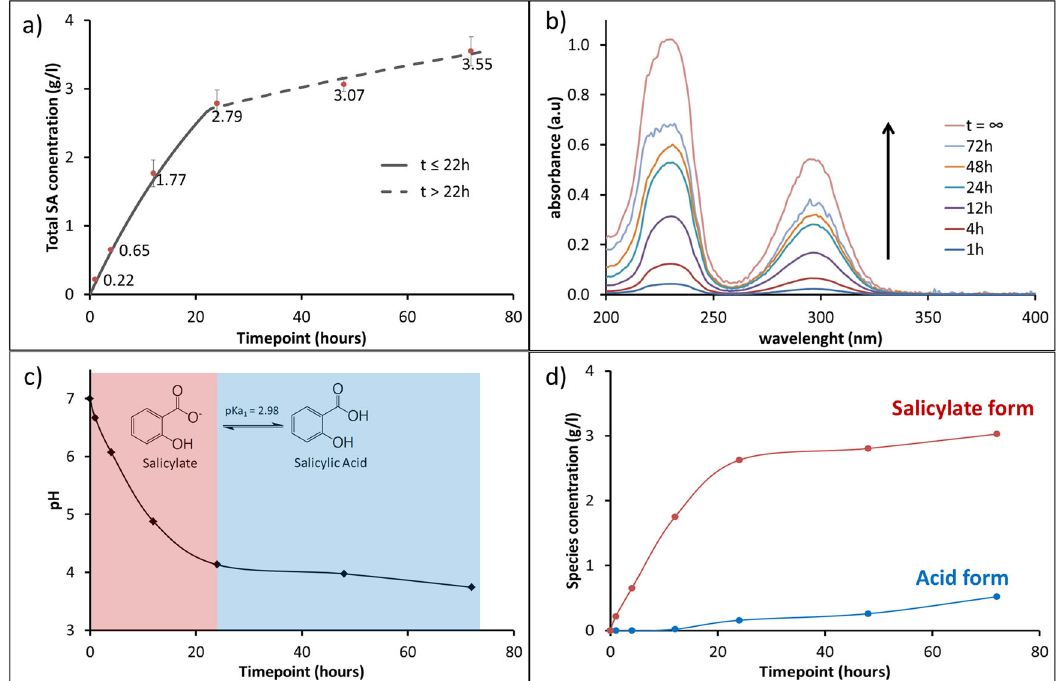
Fig. 4 Kinetics of SA release into the liquid media probed by UV-Vis spectroscopy. a Total release of SA from PDMS-SA samples showing two kinetic regimes; b Representative spectra of the released SA solutions at different time points, with vertical arrow indicating the increased concentration as a function of time and t ∞ showing the spectrum of a saturated SA solution; c pH of the release solution as a function of time; d Concentration of SA species in the release solution, i.e. protonated acid form and deprotonated salicylate as a function of